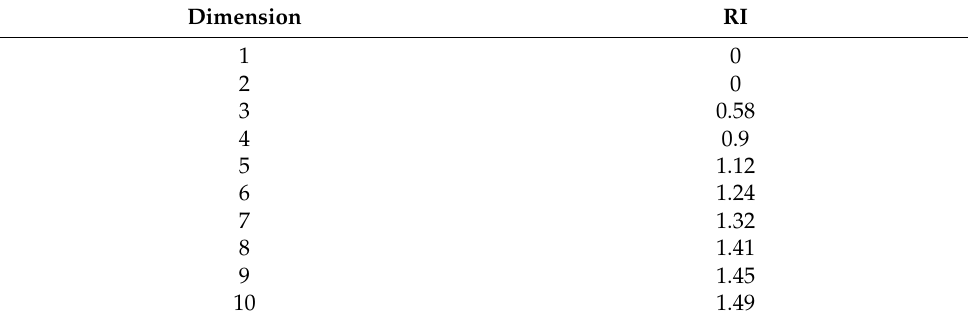
Table 5. Random Consistency Index